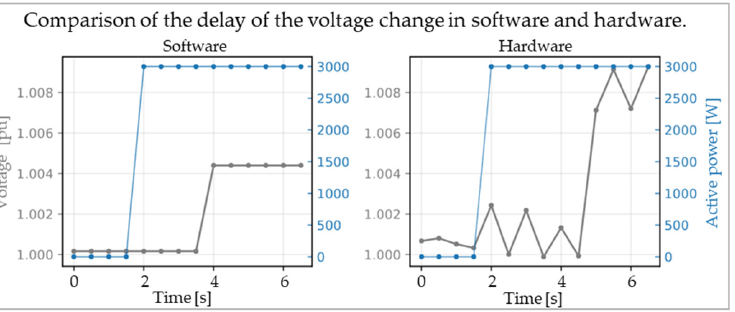
Figure 4. Comparison of the delay of the voltage change in software and hardware when changing the active power.